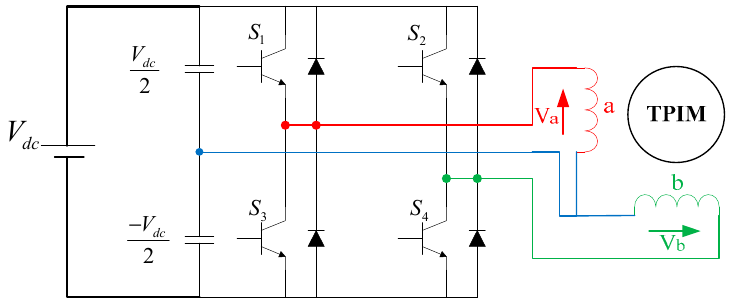
Figure 1. Two-phase induction motor drive structure.